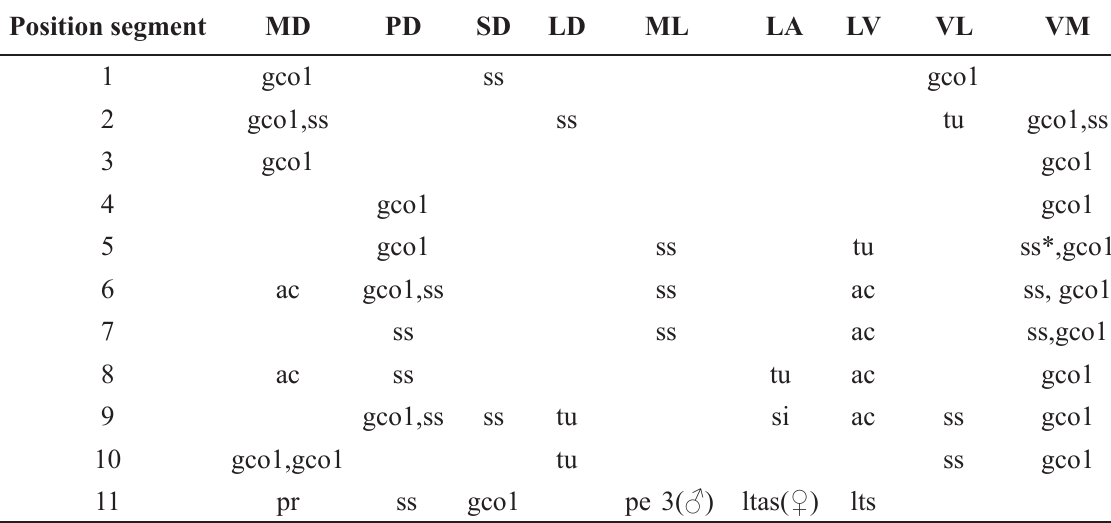
type 1 as on preceding segment. Pectinate fringe of posterior segment margin and cuticular hairs as on preceding segment.